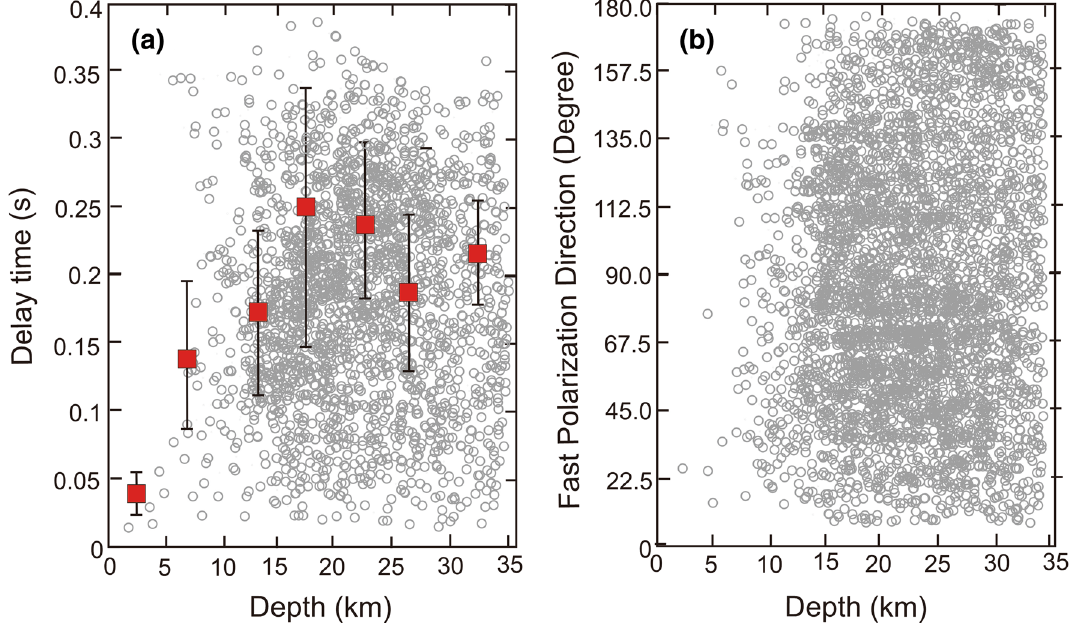
Fig. 4 a Distribution of delay time with respect to earthquake focus depth for all of the data recorded in all of the stations, shown by grey circles. The red rectangles signify the average of delay time in every 5 km depth increment. The black bars show the standard deviation of each delay time average in the increment; b distribution of fast polarization direction with respect to time, recorded in all of the